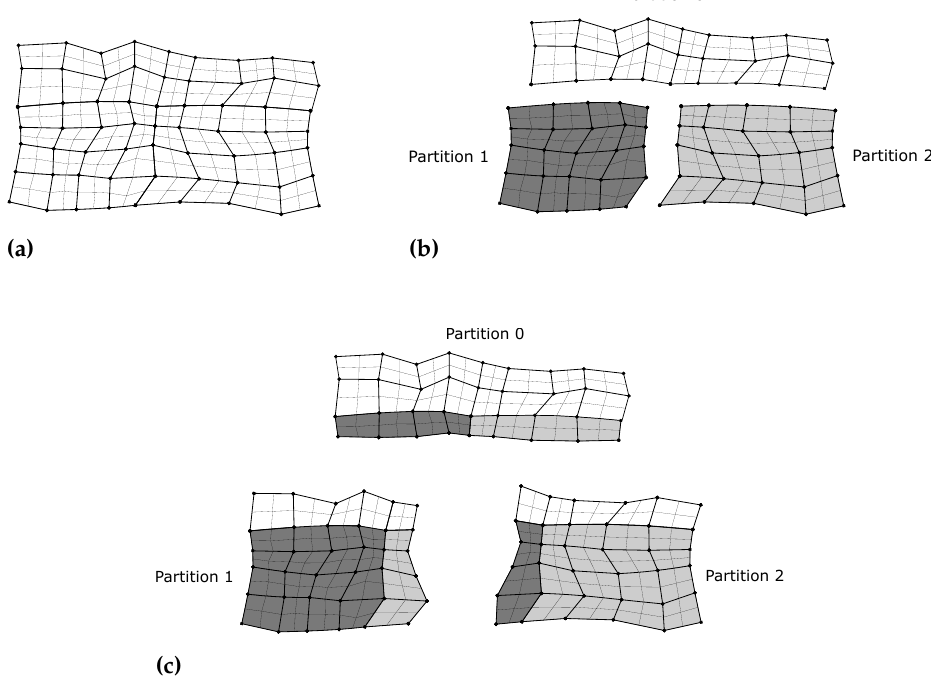
Figure 6. Mesh partitioning process for a sample mesh. (a) Sample mesh, (b) the corresponding partitions and (c) partitions with ghost elements